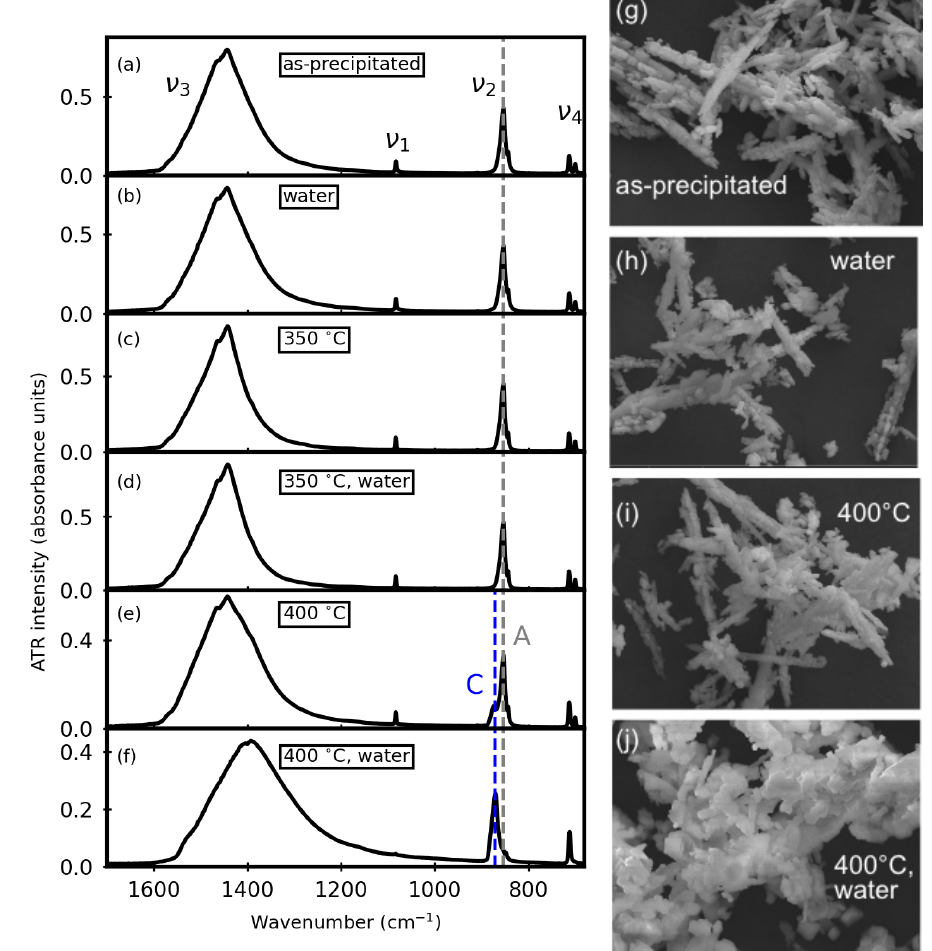
Figure 1. Representative ATR-FTIR spectra for ( a ) as-precipitated powders, ( b ) as-precipitated powders after 1 week in water, ( c ) as-precipitated powders + 350 ◦ C anneal, ( d ) as-precipitated powders + 350 ◦ C, then 1 week in water, ( e ) as-precipitated powders + 400 ◦ C anneal, and ( f ) as- precipitated powders + 400 ◦ C anneal, followed by 1 week in water. The grey vertical line (858 cm − 1 , labelled A) corresponds to the aragonite ν 2 peak, while the blue vertical line (875 cm − 1 , labelled C) shows the calcite ν 2 peak. Representative SEM images for ( g ) as-precipitated powders, ( h ) as- precipitated powders after exposure to water (1 week), ( i ) annealed, ( j ) annealed then exposed to water (1 week). Each image covers a width of 50 µ